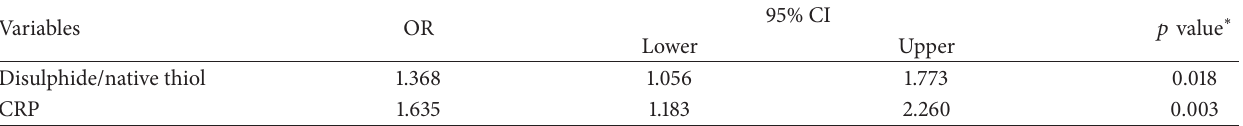
Table 4: Regression analysis and independent risk factors predicting perforated appendicitis.CRP: C-reactive